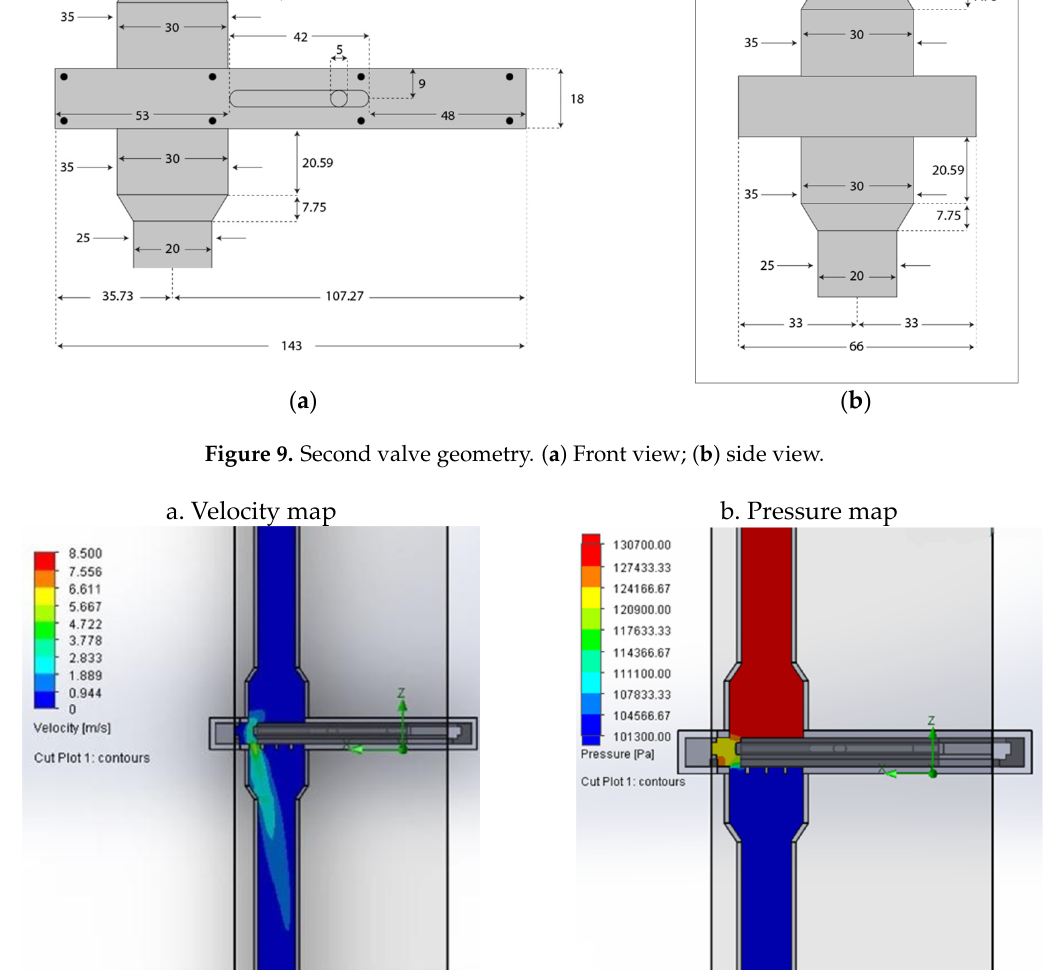
Figure 10. Second valve geometry with 10% opening.